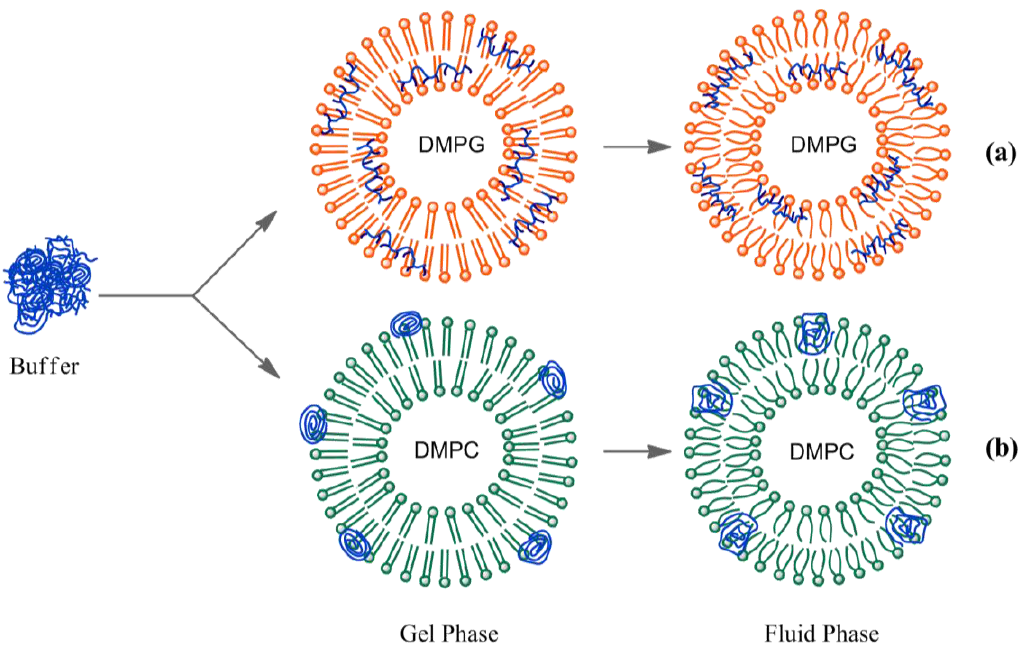
Figure 5. Schematic model, which shows the interaction between HTMA-PFP and lipid vesicles composed of ( a ) anionic and ( b ) zwitterionic vesicles in gel and fluid phases.